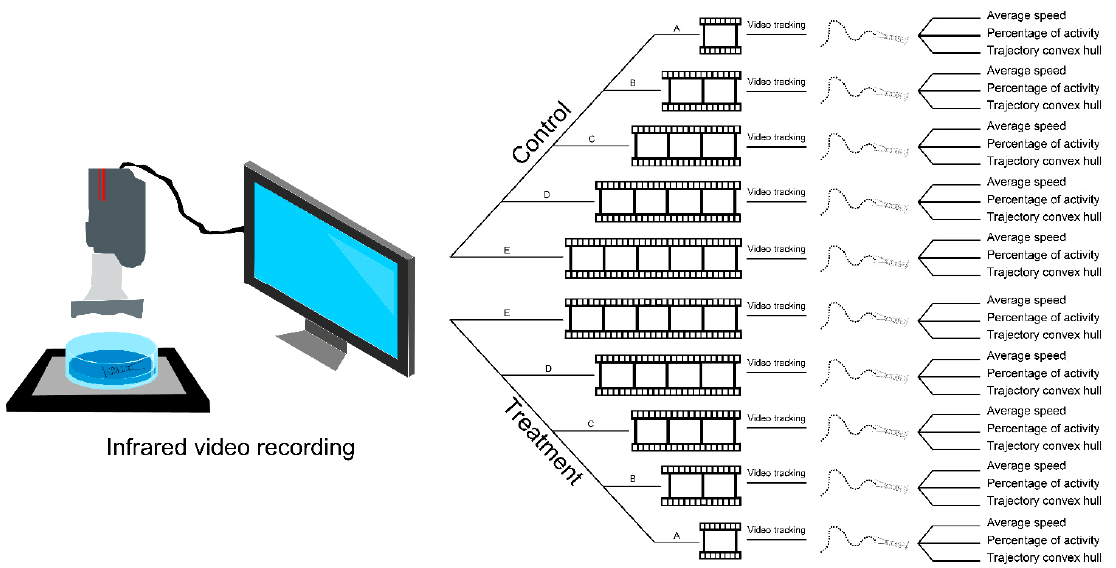
Figure 1. Graphical representation of the experimental design: from the trajectory recording to the computation of the behavioural parameters. A = one minute of recording (1800 video frames); B = two minutes of recording (3600 video frames); C = three minutes of recording (5400 video frames); D = four minutes of recording (7200 video frames); E = five minutes of recording (9000 video frames) for both controls and treatments.